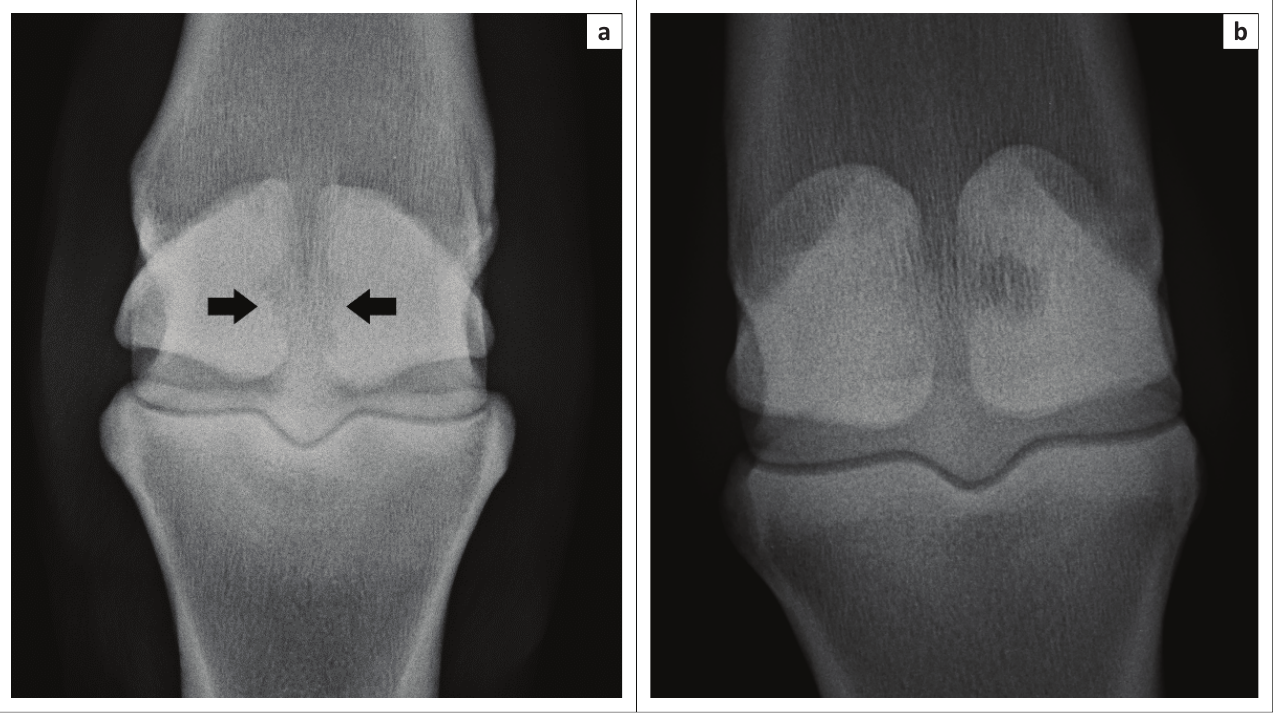
FIGURE 3: Dorsoproximal-palmarodistal oblique radiographs of the (a) left metatarsophalangeal joint of a 6-year-old Friesian stallion (b) and of the left metacarpophalangeal joint of a 15-year-old warmblood mare. Lateral is to the right of the